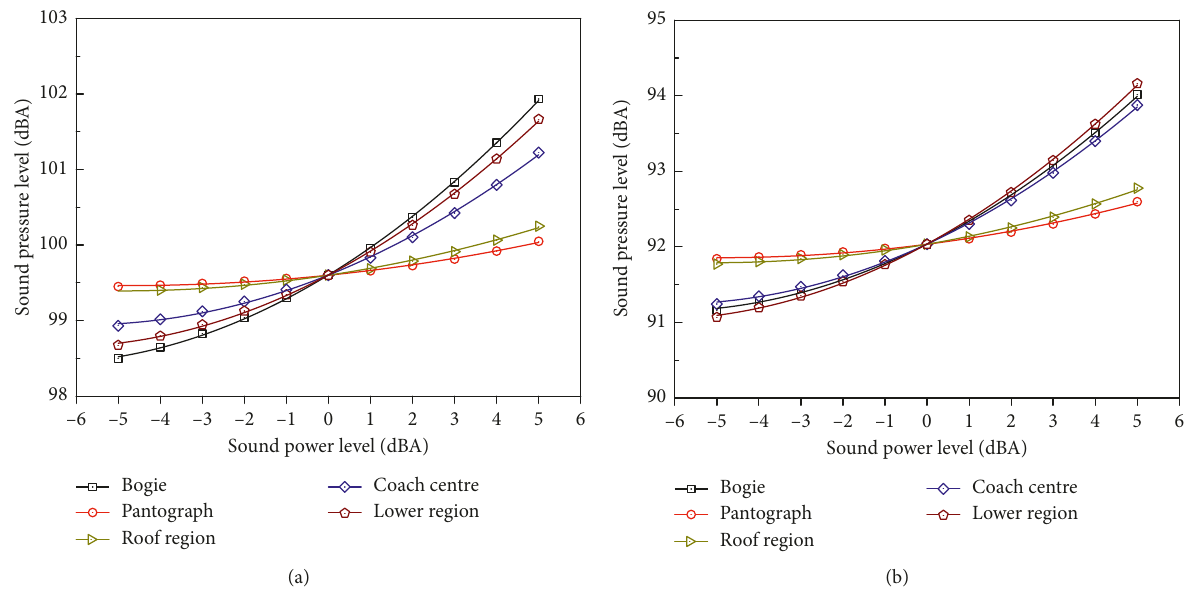
Figure 18: Influence of different sound sources on the pass-by noise. (a) 7.5m from the centreline of the track; (b) 25m from the centreline of the